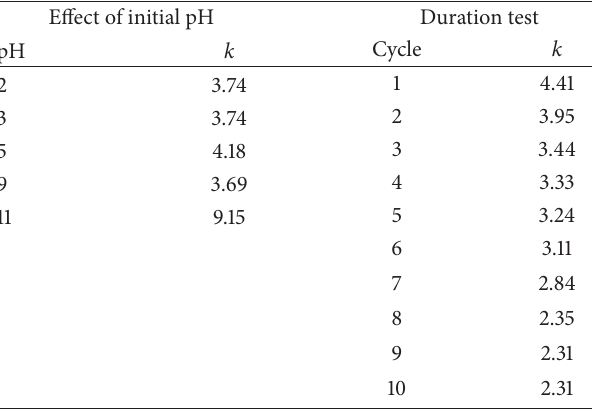
Table 3: The first-order reaction rate constant k (10 2 min − 1 ) for operating parameter of pH and